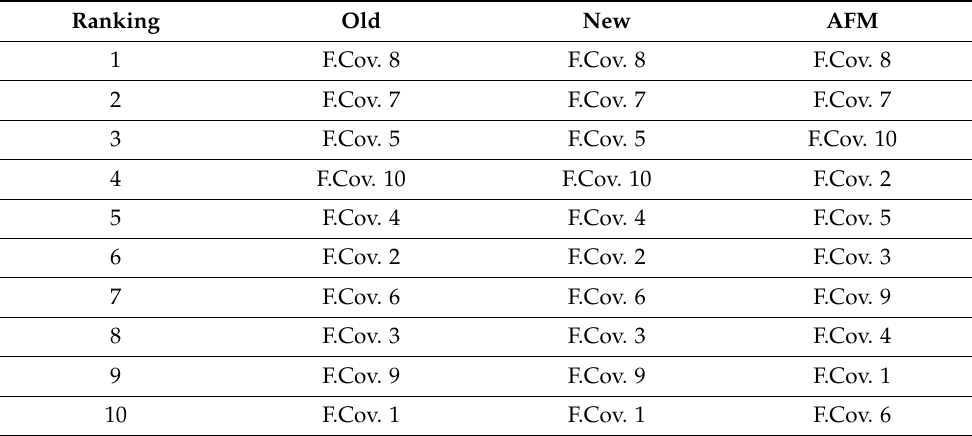
Table 6. Ranking of floorcoverings with respect to the generation of electrostatic charges at different